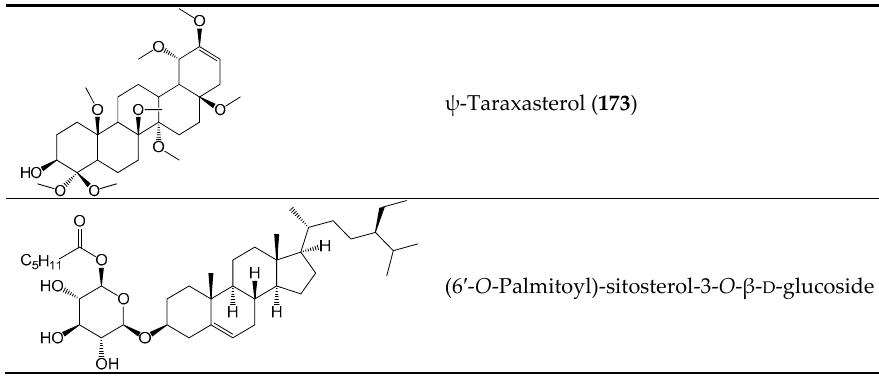
Figure 5. Chemical structures of sterols in Forsythiae Fructus.